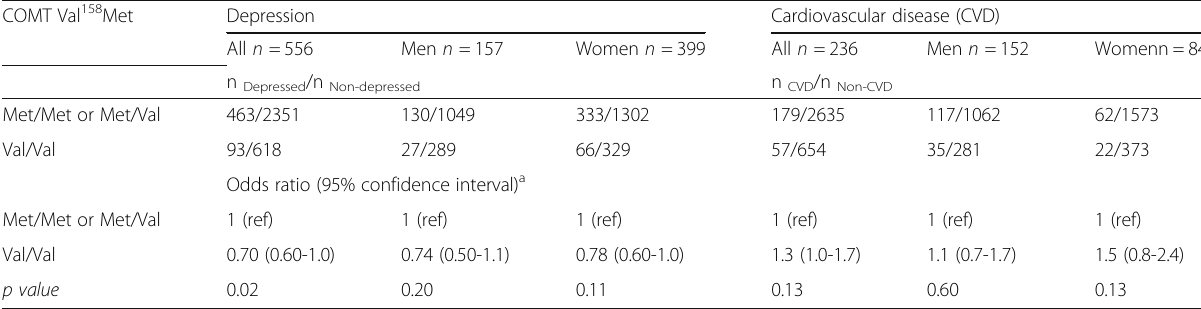
Table 2 Association of COMT Val 158 Met with depression and cardiovascular disease; stratified by gender COMT Val 158 Met